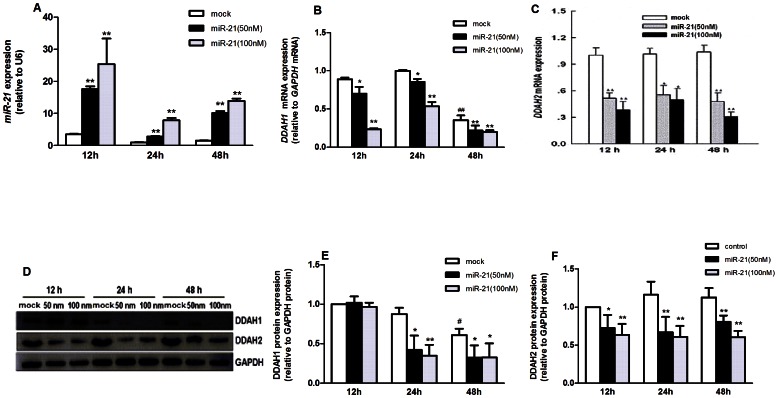
Effects of miR-21 transfection on DDAH expression and intracellular ADMA level in cultured HUVECs.Data were expressed as means±SEM (n = 3). A. Expression of miR-21 in HUVECs at different time point after miR-21 transfection. **p<0.01, compared with the control group at each time point; B. Relative expression of DDAH1 mRNA in HUVECs after miR-21 transfection. *
p<0.05, **
p<0.01, as compared with the control at corresponding time point; ##
p<0.01, as compared with the control group at 12 h; C. Expression of DDAH2 mRNA in HUVECs after miR-21 transfection. *
p<0.05, **
p<0.01, as compared with the control group at corresponding time point. D. Western blot analysis of DDAH1 and DDAH2 expression after miR-21 transfection. E and F. Semi-quantitative expression of DDAH1 and DDAH2 protein expression in HUVECs after miR-21 transfection. *
p<0.05. **
p<0.01, as compared with control group at corresponding time point; #
p<0.05, as compared with the control group at 12 h.